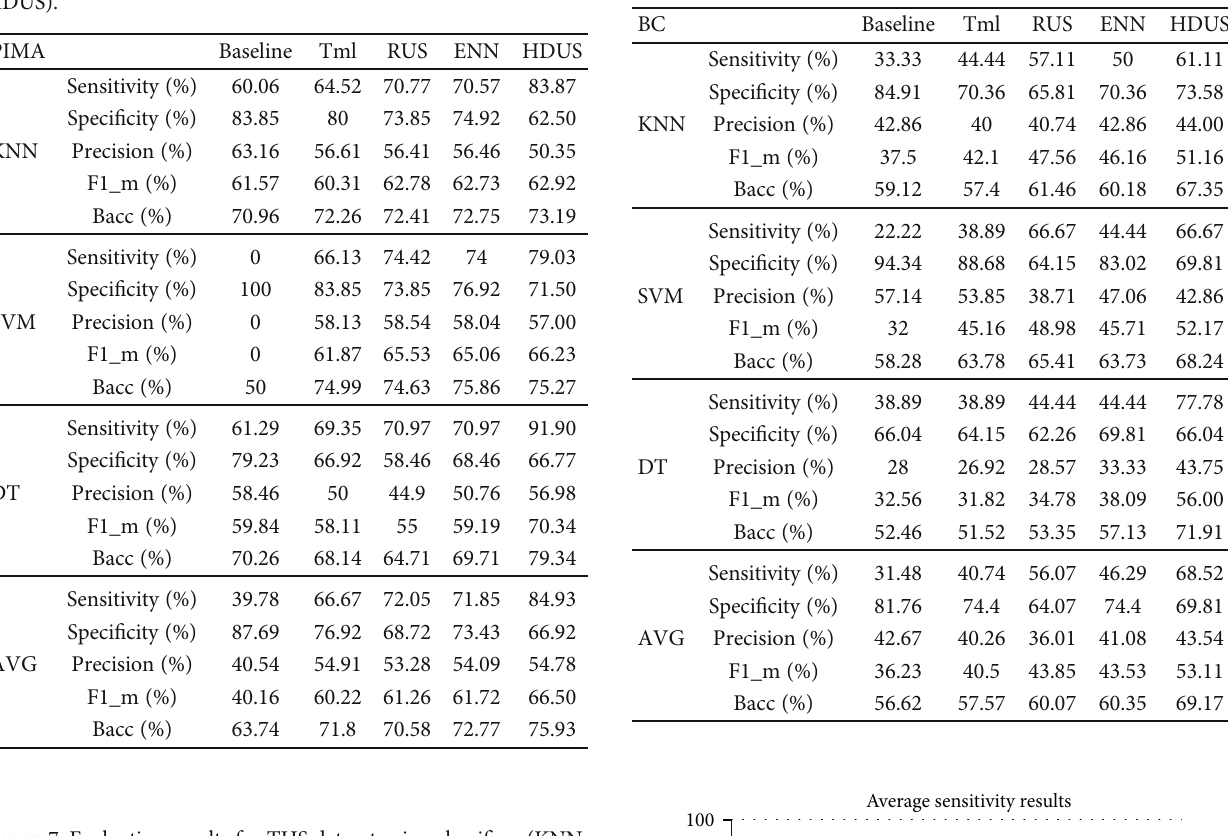
Table 8: Evaluation results for BC dataset using classi fi ers (KNN, SVM, and DT) and models (baseline, Tml, RUS, ENN, and HDUS).